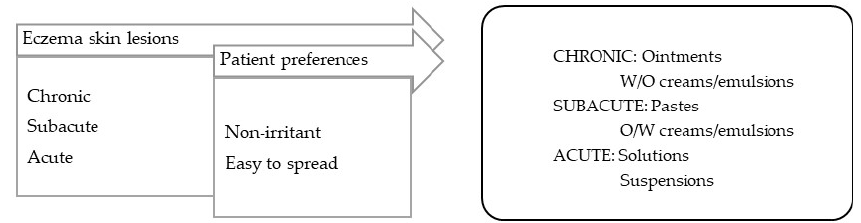
Figure 2. TPP for formulations for eczema-lesion treatment and most suitable vehicles/bases.